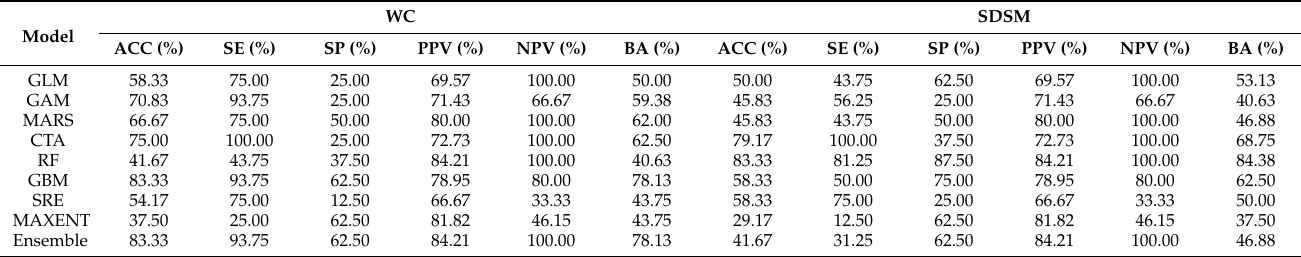
Table 3. Field ground-truthing validation using the accuracy (ACC), sensitivity (SE) specificity (SP), positive predictive value (PPV), negative predictive value (NPV), and balanced accuracy (BA). WC SDSM Model ACC (%)